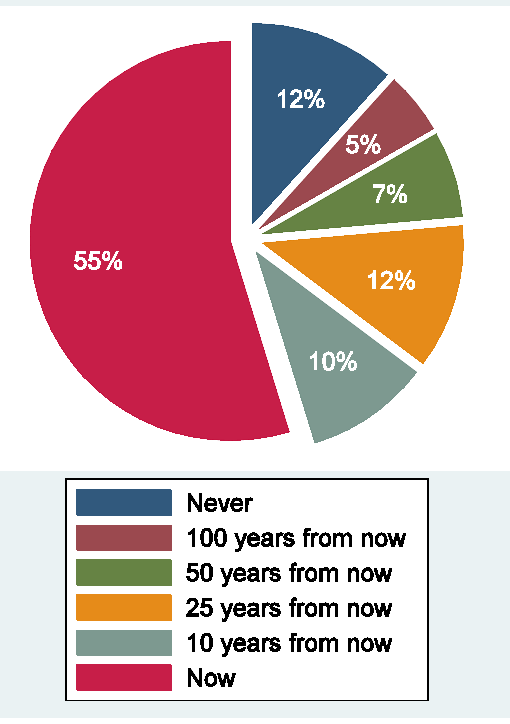
Figure 4. Stakeholders’ perception of climate change’s effect on coral reefs.